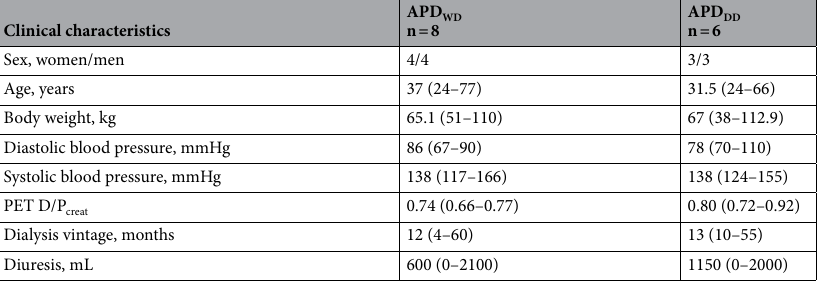
Table 1. Clinical characteristics of 14 patients undergoing APD with remote patient monitoring allowing recording of volumes of infusion and drainage of dialysate; patients were undergoing APD with wet day regime (APD WD ) or dry day regime (APD DD ). Data are median (min–max) if not stated otherwise. For blood pressure and body weight, the mean values for each patient over 16 days were noted. PET D/P creat - Peritoneal Equilibration Test dialysate-to-plasma concentration of